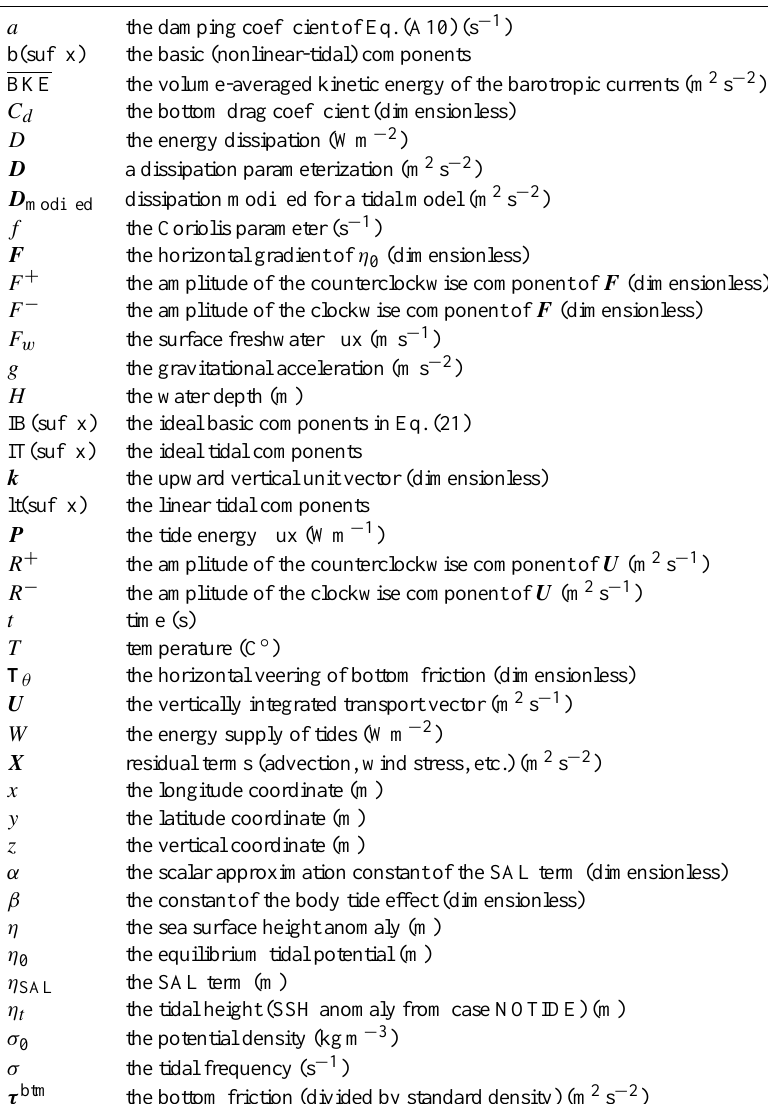
Table 1. Mathematical variables and constants in the main text and